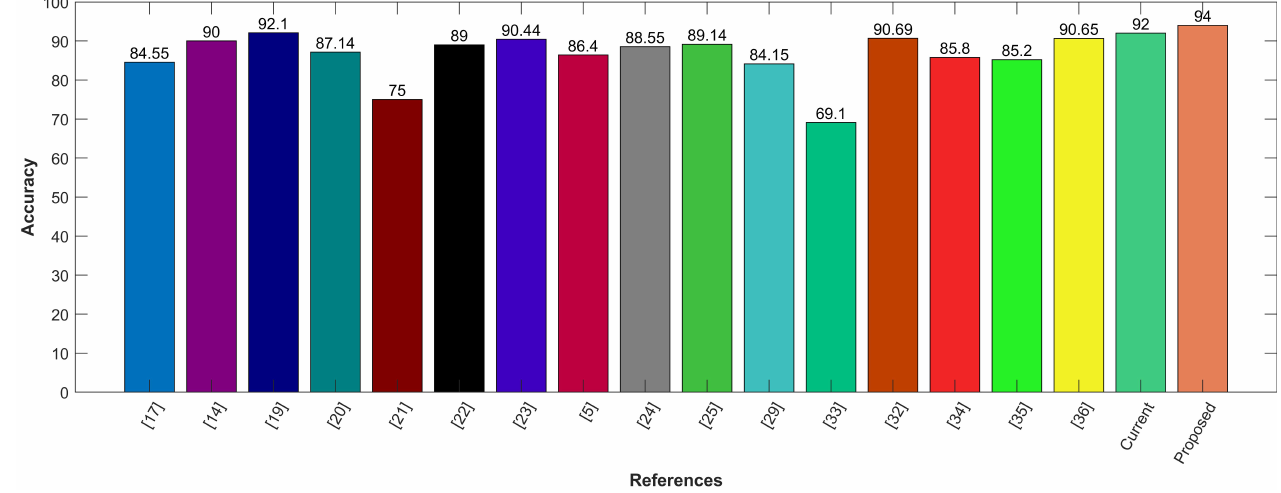
Figure 11. Comparison with other existing CAD